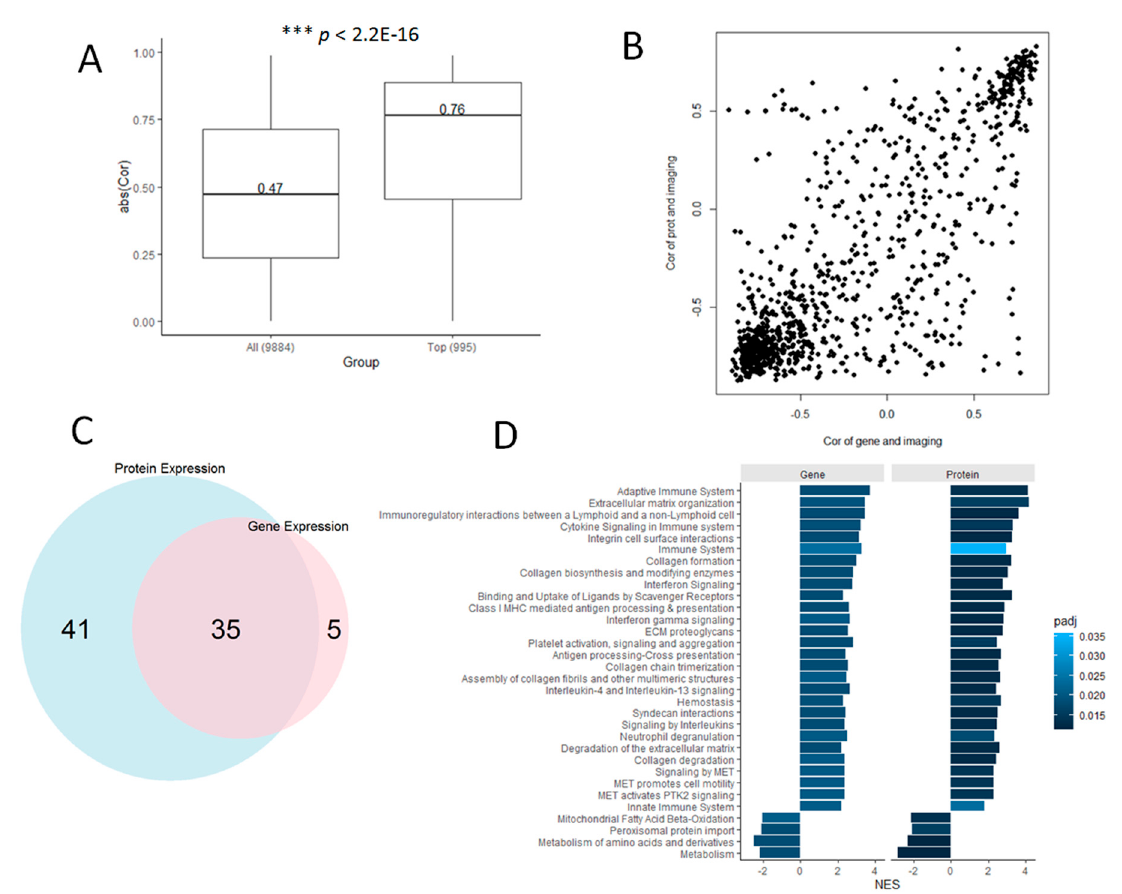
Figure 5. Protein and gene expression data are highly concordant in the diagnosis of clear cell renal cell carcinomas (CCRCC). ( A ) Box plot of the gene-protein expression correlations observed in our set of 995 proteins, compared to distribution of correlation values observed in the full set of proteomics dataset with available gene expression data. ( B ) Correlation plot of protein expression-image prediction correlations (vertical axis) vs. gene expression-image prediction correlations (horizontal axis). ( C ) Number of overlapping molecular (Reactome) pathways statistically detected (with GSEA) in the protein and gene expression datasets independently, on the basis of their correlations with the image-based predictions. ( D ) List of significantly enriched 35 pathways shared in common by the protein and gene expression datasets. Bars indicate the magnitude of the enrichment scores, and adjusted P-values of the enrichments are color coded.